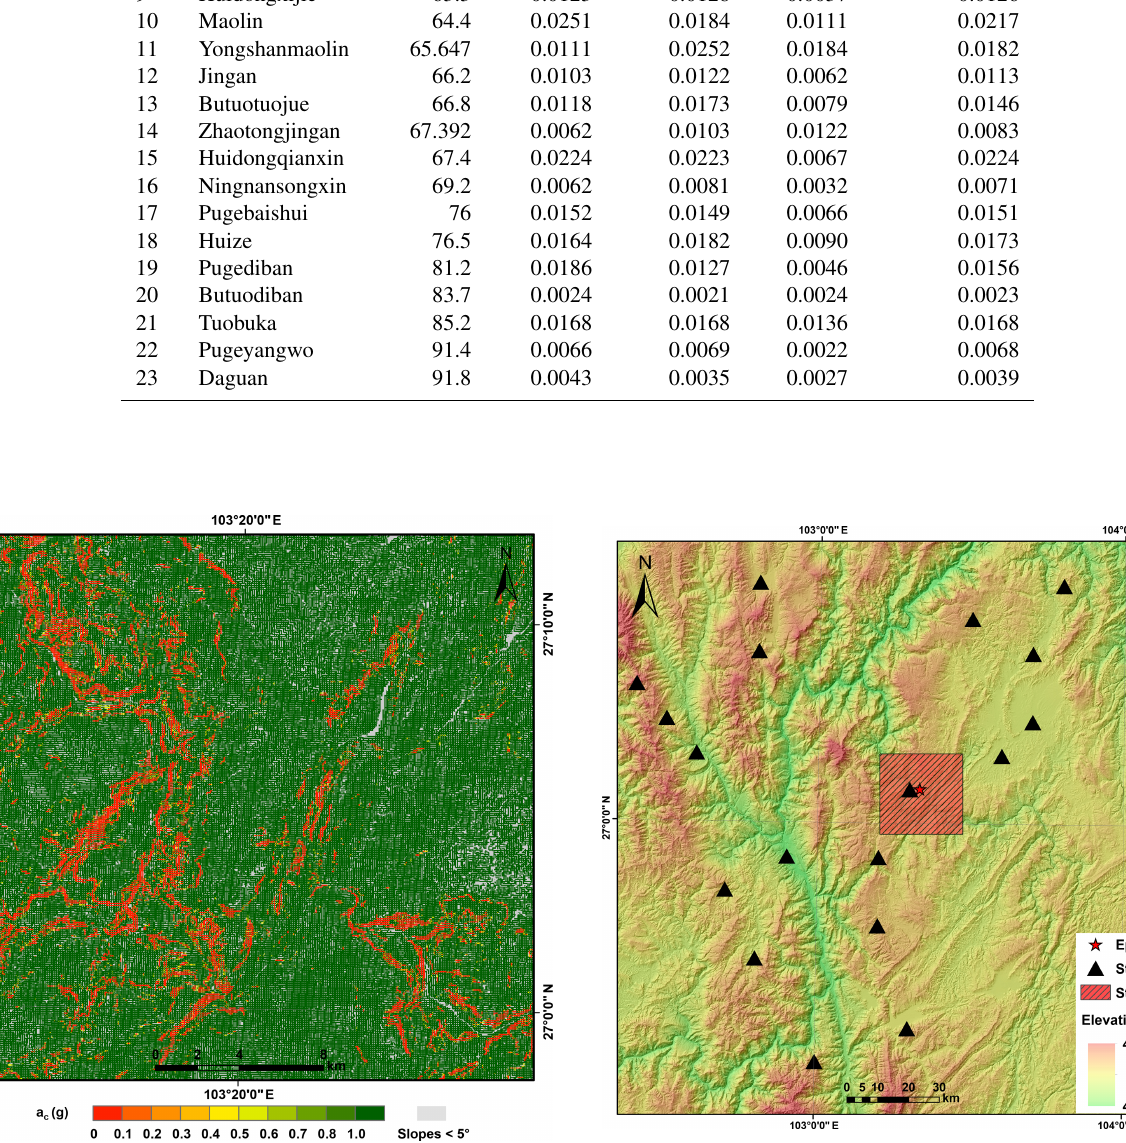
Figure 14. Locations of strong motion